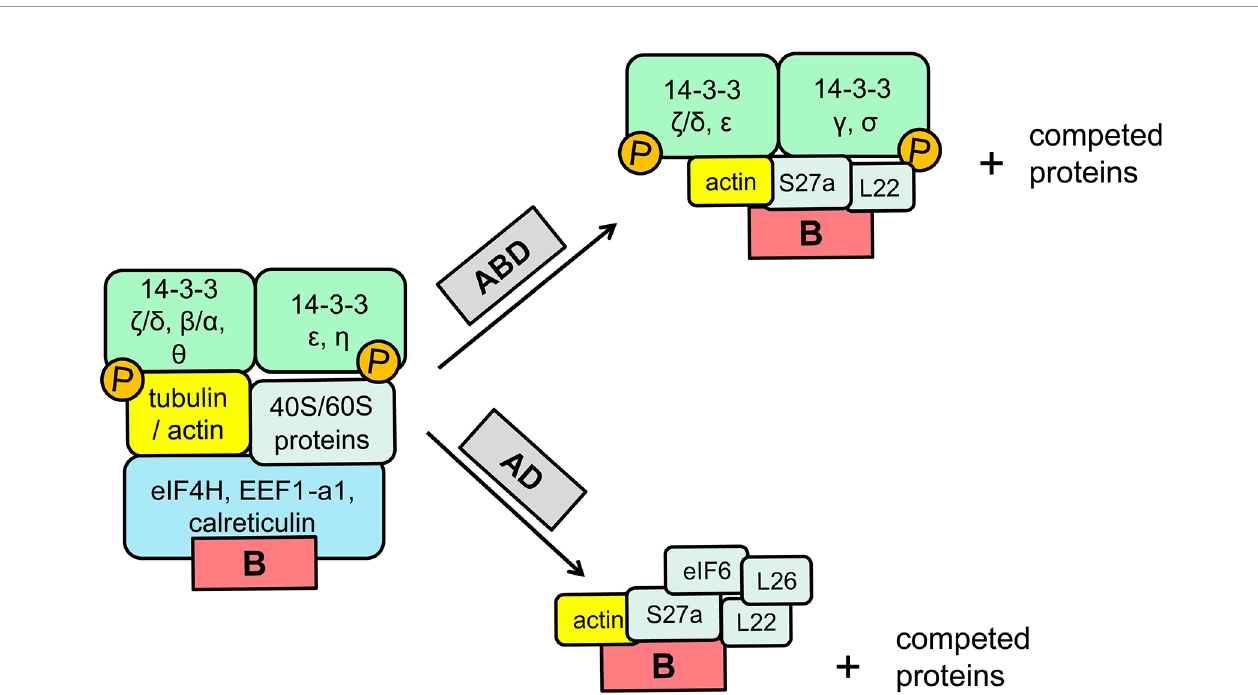
FIGURE 2 | Schematic representation of the proteins present in the eB-mediated shifts before and after competition with excess of ABD or AD RNAs [adapted from Noutsios et al. (87)]. The identity of the proteins present in the shifts before and after competition were identi fi ed with mass spectroscopy, as described in detail elsewhere (86,